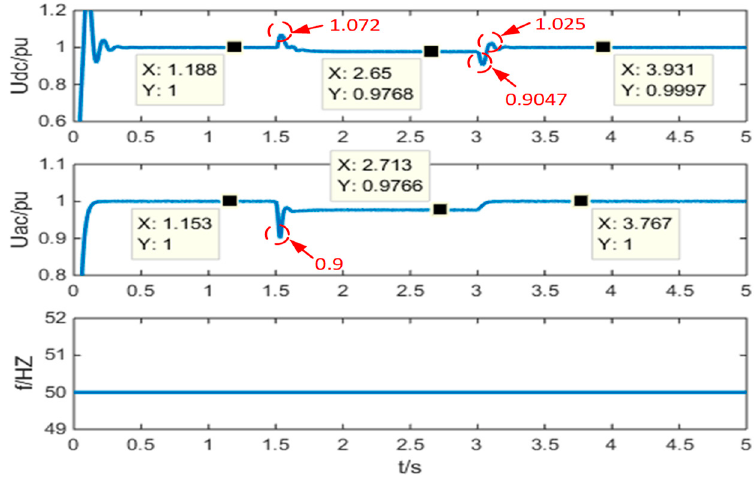
Figure 11. DC voltage, AC voltage, and frequency with traditional smooth transition control.